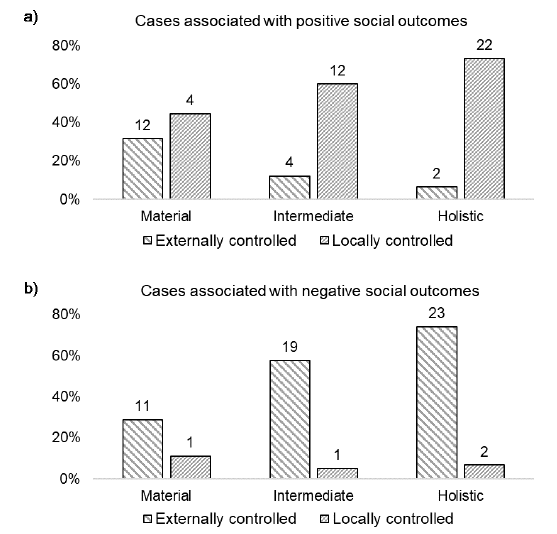
Fig. 4 . The proportion of the 169 reviewed cases characterized by (a) predominantly positive social outcomes; and (b) predominantly negative social outcomes, each displayed by social research approach applied and conservation governance